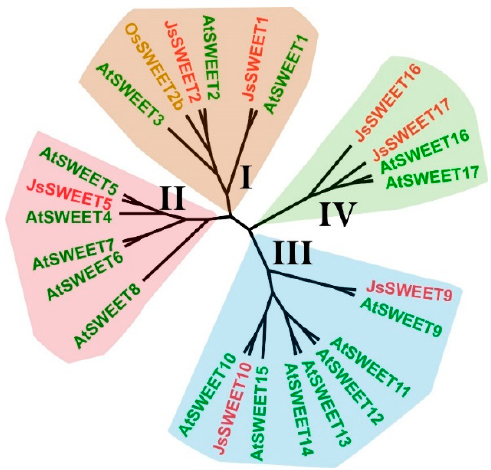
Figure 2. A phylogenetic tree showing the sequence relationship between the seven cloned J. sambac SWEET transporters (in red) and the seventeen members from Arabidopsis (in green), together with the rice homolog, OsSWEET2b (in yellow), which has a solved structure (PDB ID: 5CTH) available.